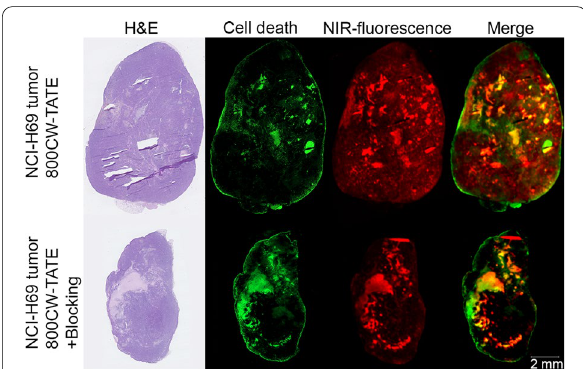
Fig. 4 Consecutive sections of paraffin-embedded NCI-H69 tumor xenografts from mice, tumors resected 4 h post-injection with either 3 µg 800CW-TATE (top) or 3 mg DOTA-TATE (as a blocking agent from SSTR 2 ) and 3 µg 800CW-TATE (bottom). From left to right are depicted H&E staining, fluorescent cell death staining (TUNEL), NIR-fluorescent signal from 800CW-TATE uptake, and a merging of dead cell staining and